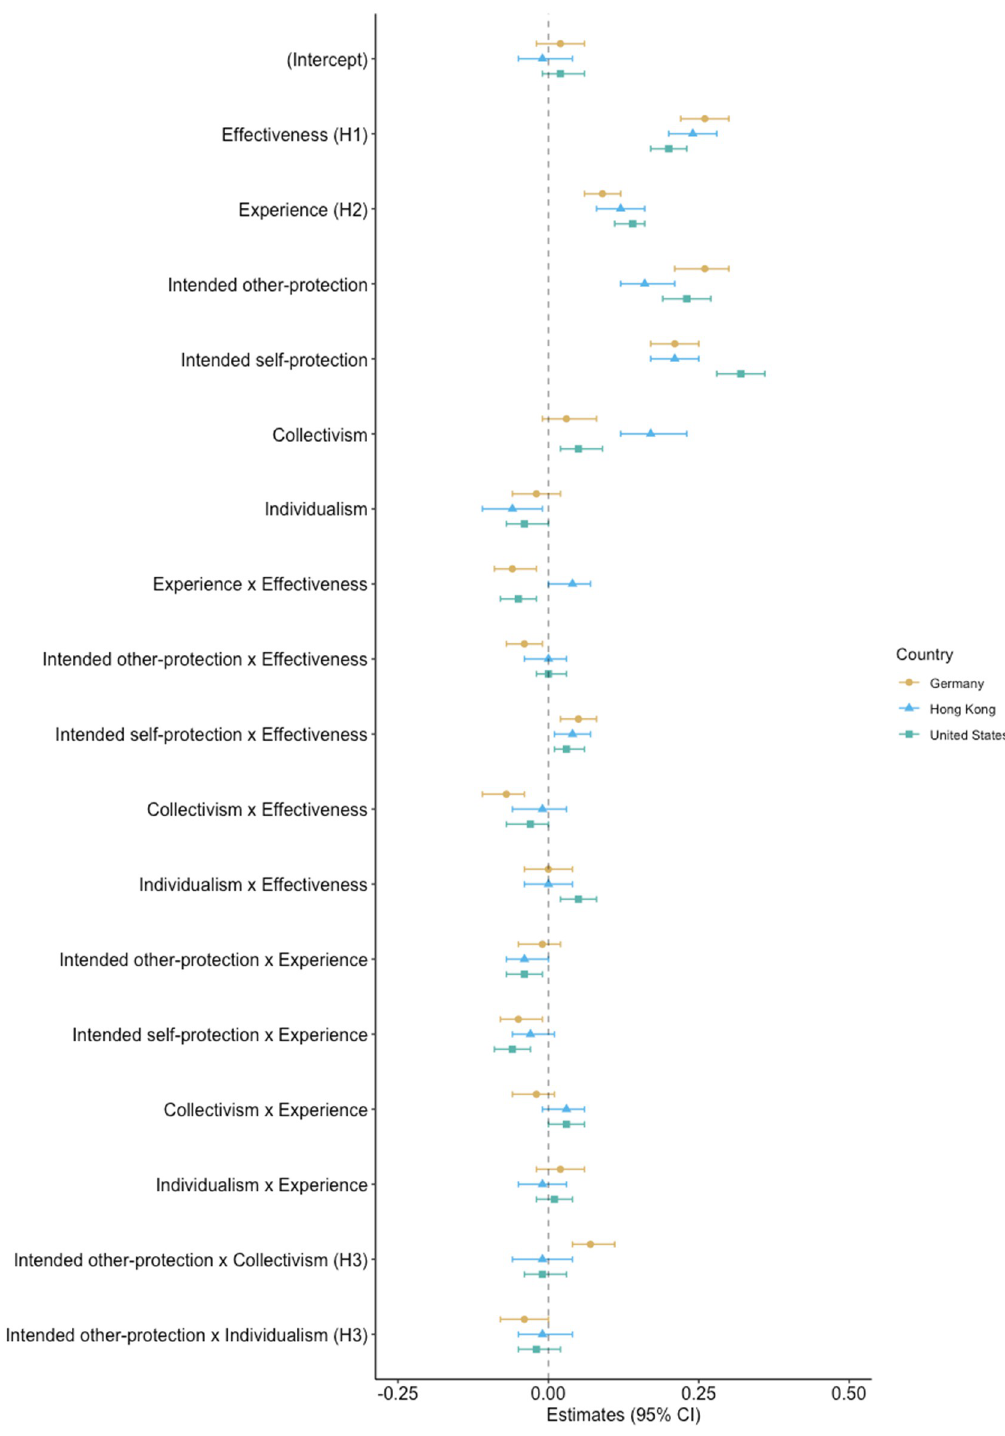
Fig 2. Predictors of willingness to adopt the measures per country. Standardized coefficients from Model 2 separately for each country. H1, H2, and H3 correspond to the three preregistered hypotheses.